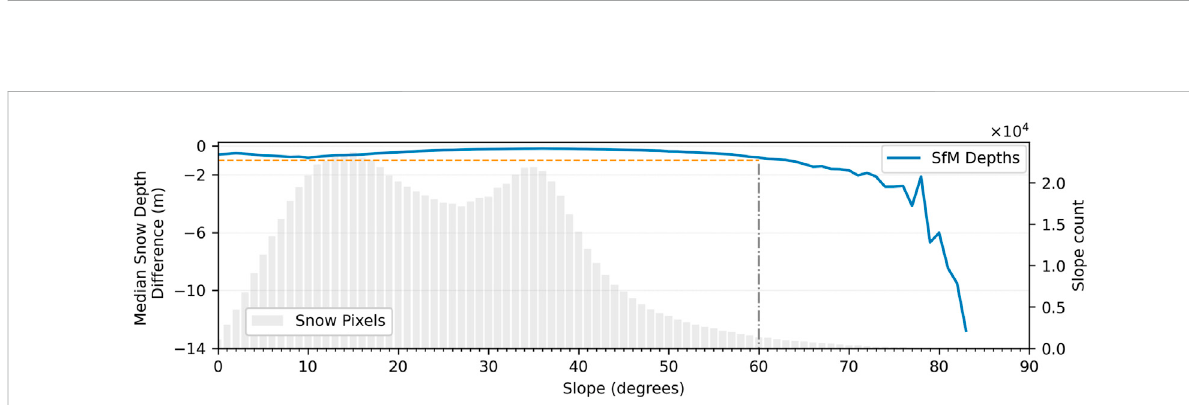
FIGURE 8 The median snow depth difference for negative SfM values in open areas binned by slope angles stayed below -1 m (orange dashed line) until 60 ° C (grey dotted-dashed lines), before increasing sharply with most of the terrain below this slope angle (grey histogram). This trend was the only strong relationship detected when analyzing the negative SfM values for possible in fl uences due to